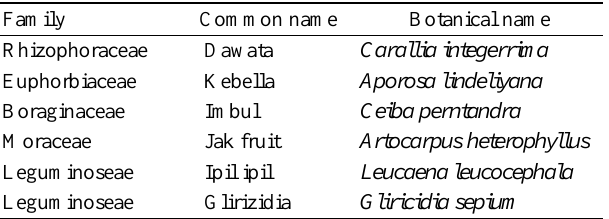
Table 1. Leguminous and non-leguminous forage species used for the experiment Family